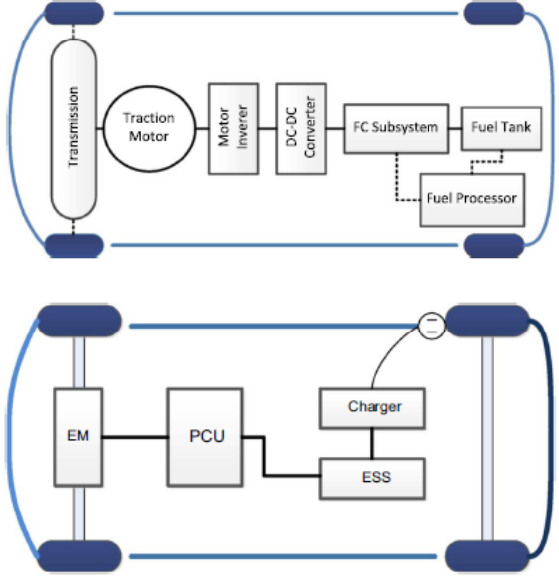
Fig. 2. Configuration battery and fuel cell electric propulsions